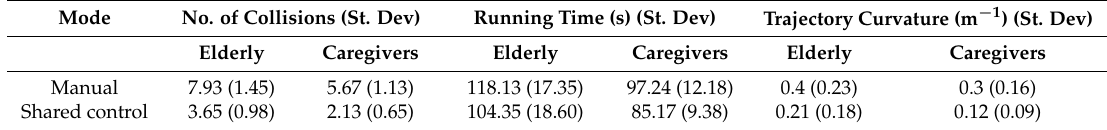
Table 1. Comparison between the two modes of control—mean values and standard deviation.